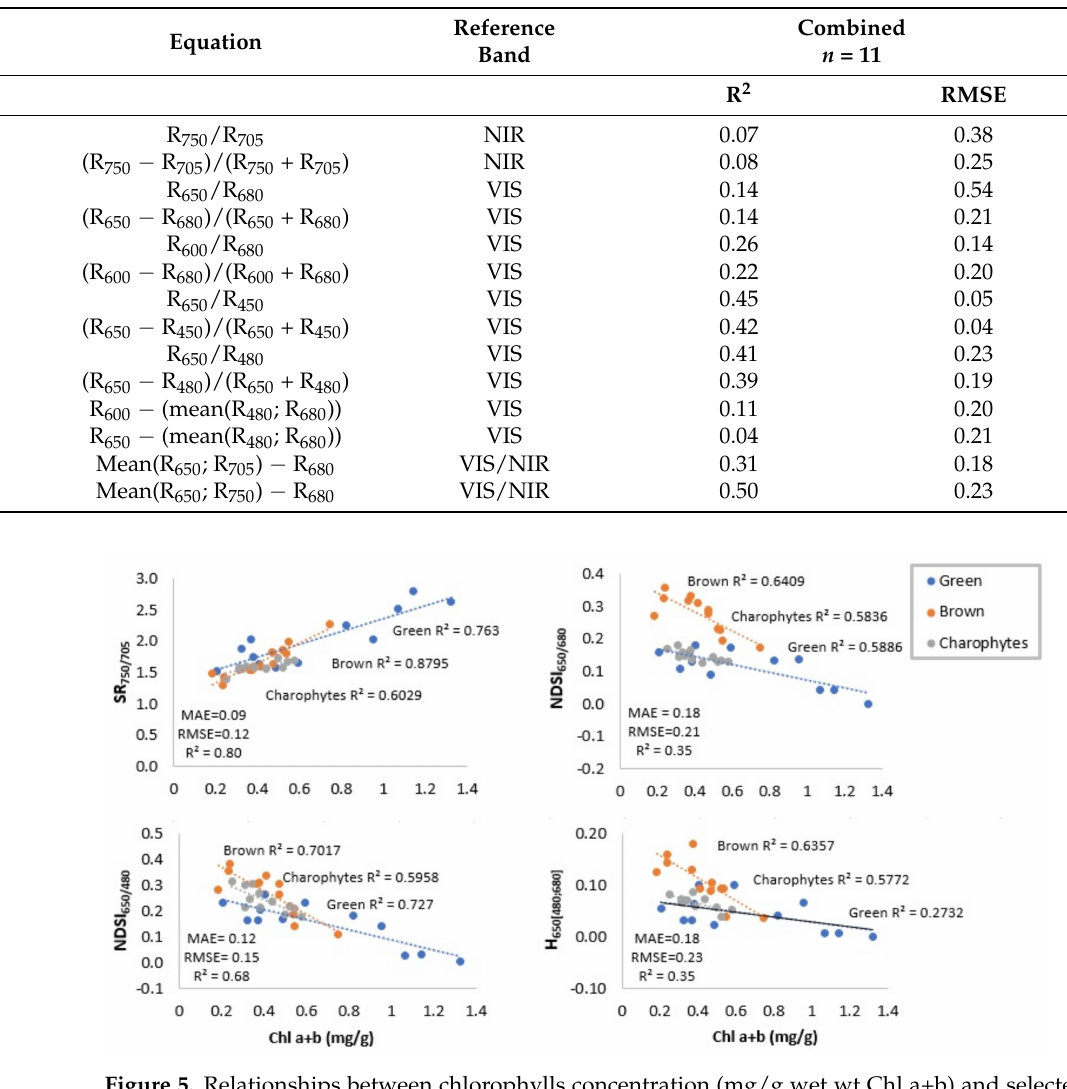
Table 3. The coefficient of determination (R 2 ) and root mean square error (RMSE) between chlorophyll concentration (mg/g wet wt Chl a+b) and spectral indices for the UW dataset. R 2 and RMSE are given only for combined classes incorporating green macroalgae, brown macroalgae, charophytes, and higher plants.